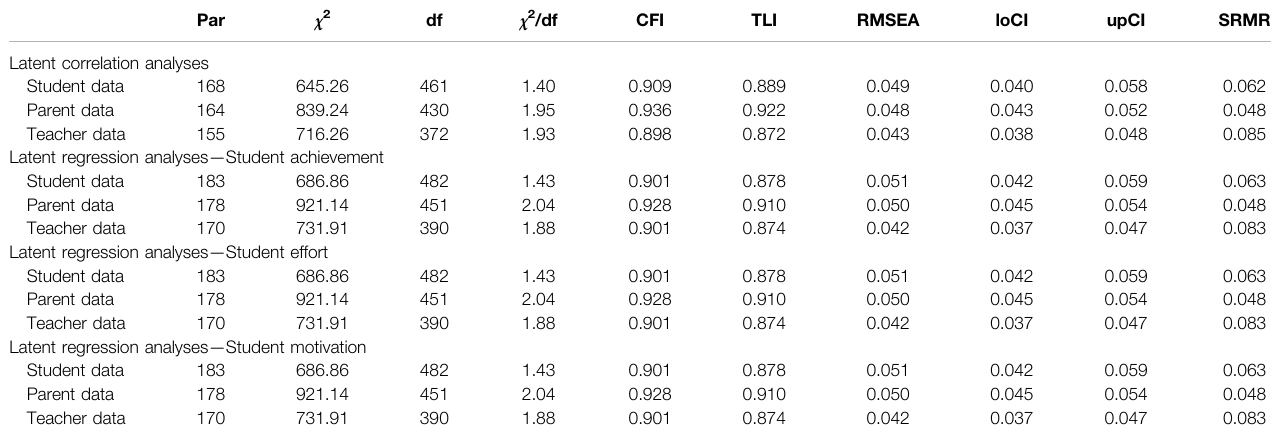
TABLE 3 | Model fi t of latent correlation and latent regression